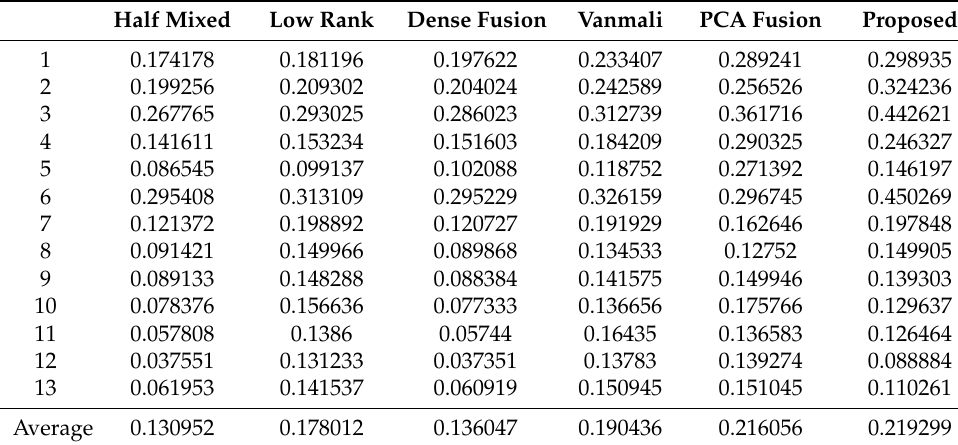
Table 2. Comparison of the VIFF